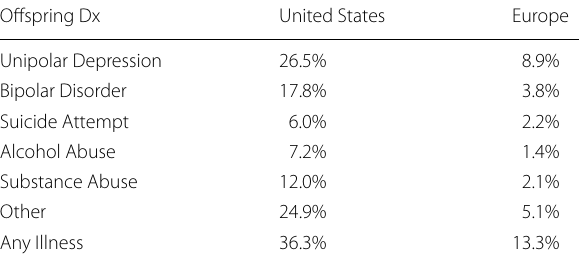
Table 2 Comparison of the offspring of BCN participants in the US and Europe demonstrating a greater burden